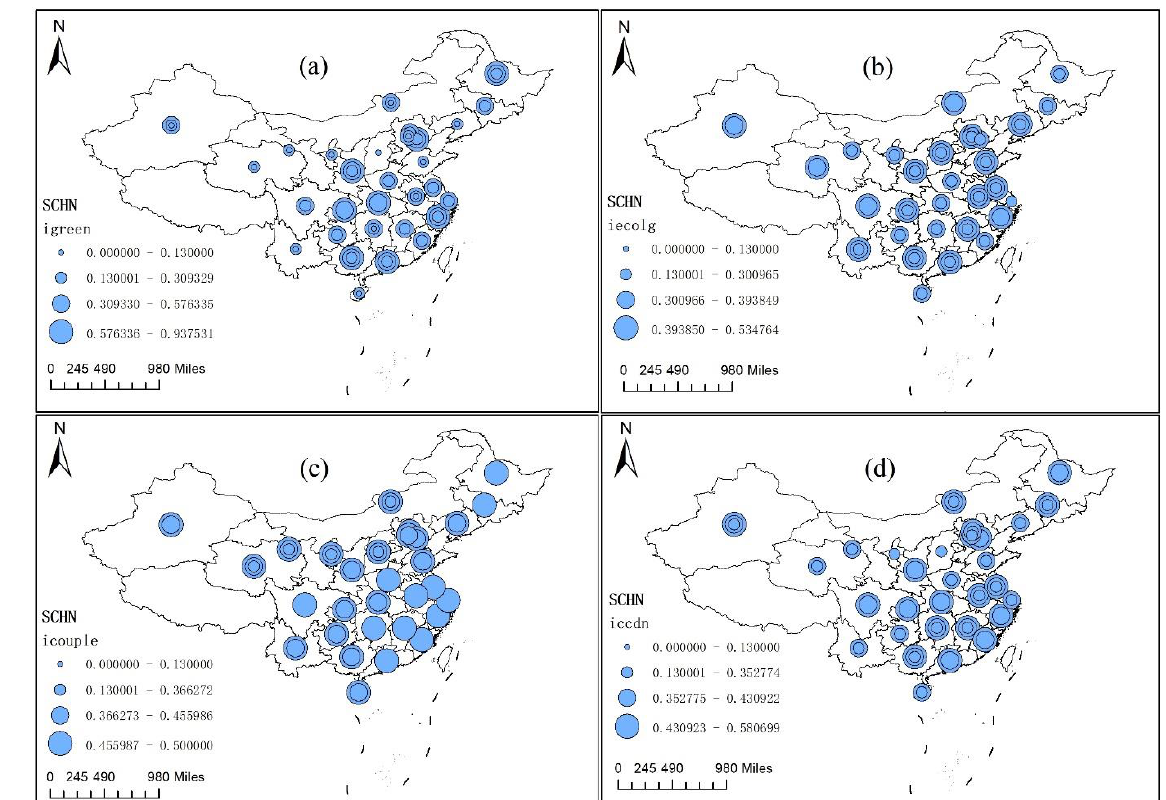
Figure 2. The evolutionary trend of related indices from 2003 to 2020. Note: (1) The symbol ( a – d ) refers to the green finance index, the ecological environment index, the coupling index between green finance and the ecological environment, and CCFE respectively.